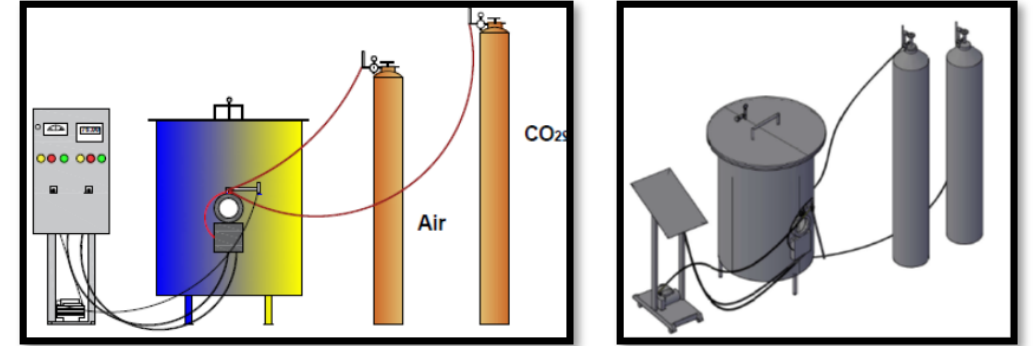
Figure 2: CO 2 -curing experimental